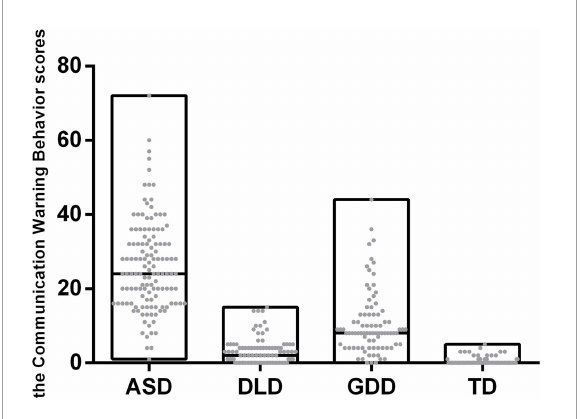
FIGURE2 Communication warning behavior score distribution of different groups.